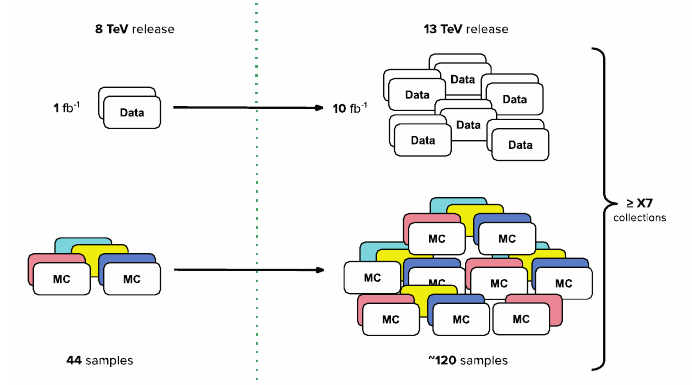
Figure 1. Evolution of ATLAS Open Data from the 8 TeV release (2016) to the 13 TeV release